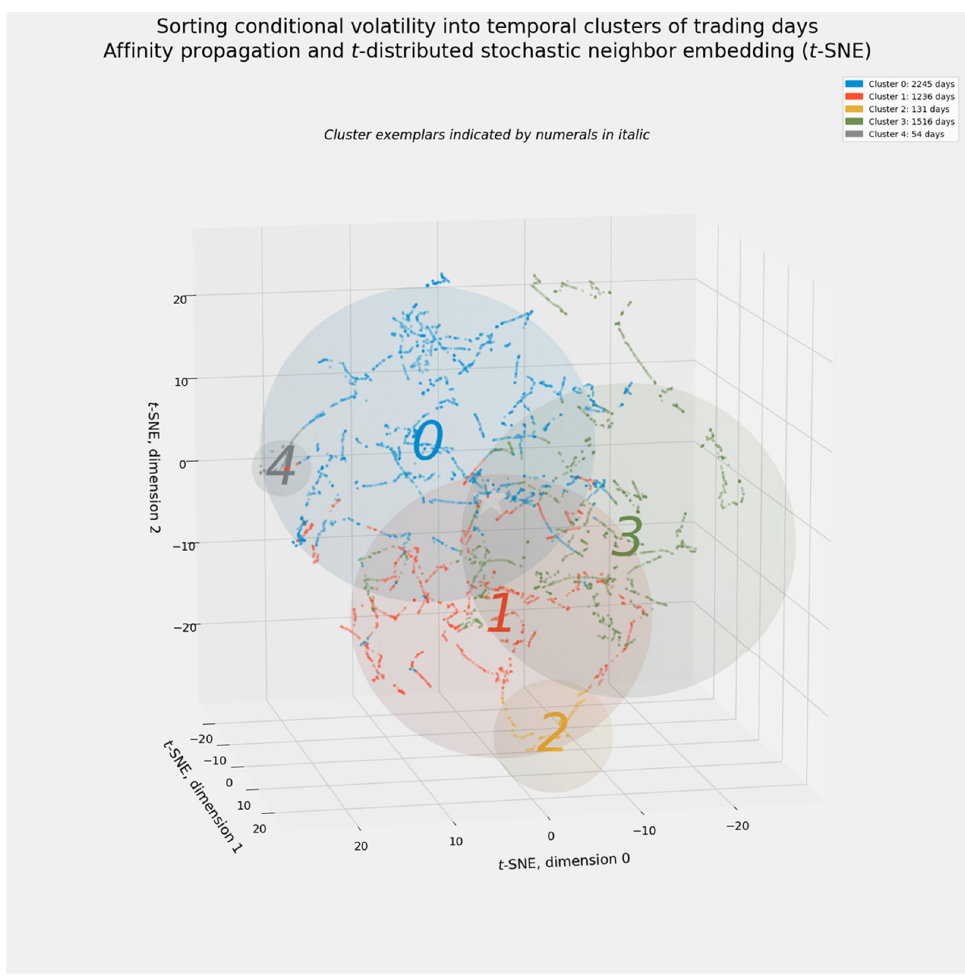
Figure 13. Affinity propagation of commodity markets—A t -SNE manifold.